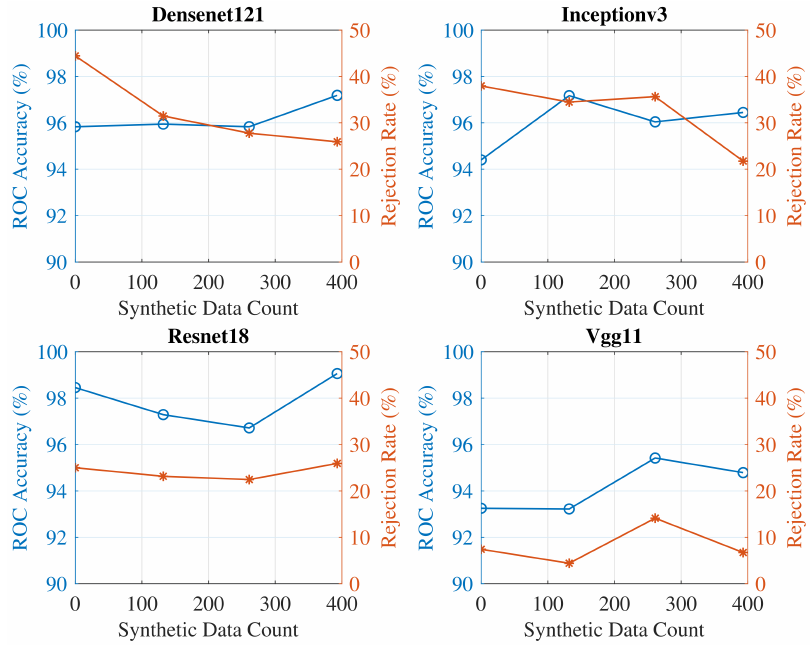
Figure 9. Response of networks after ROC analysis with increasing levels of synthetic data.These results correspond to configurations C1, C2, C3, and C4. The orange lines represent the rejection rates of the networks, whilst the blue lines represents the accuracy after ROC